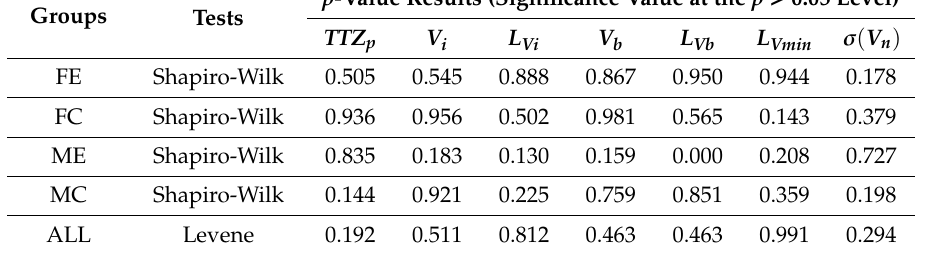
Table 2. Checking ANOVA test assumptions. Legend: the first four rows report the result of the Shapiro-Wilk normality test ( p -values) for each of the four groups considered in the study (i.e., FE, FC, ME, MC) and separately for each variable of the speed profile (i.e., TTZ d , V i , L Vi , V b , L Vb , L Vmin , σ ( V n ) ); the last row reports the result ( p -values) of the variance homogeneity test (or Levene’s test) that checks whether the variance in scores is the same for each of the four groups, separately for each variable of the speed profile. p -Value Results (Significance Value at the p > 0.05 Groups Tests